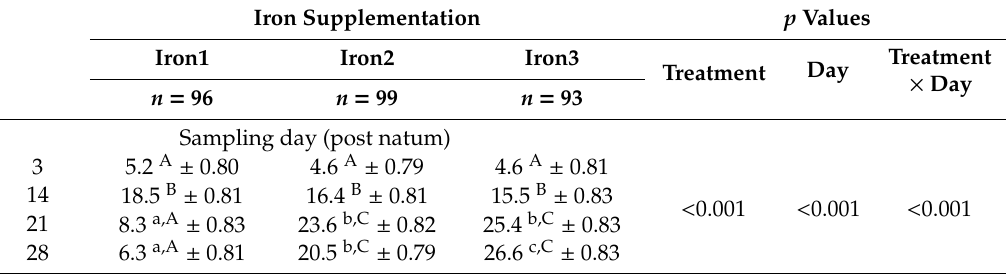
Table 3. E ff ect of supplementing iron by subcutaneous injection to organically reared piglets on their third day of life only (Iron1), on day 3 and 14 (Iron2) and on day 3, 14 and 21 (Iron3) on serum iron content ( µ mol L − 1 ). Results are given as least square estimates ± SEMs of the interaction treatment * day and p values for the e ff ects of treatment, day and treatment * day and were calculated using SAS PROC MIXED. Iron Supplementation p